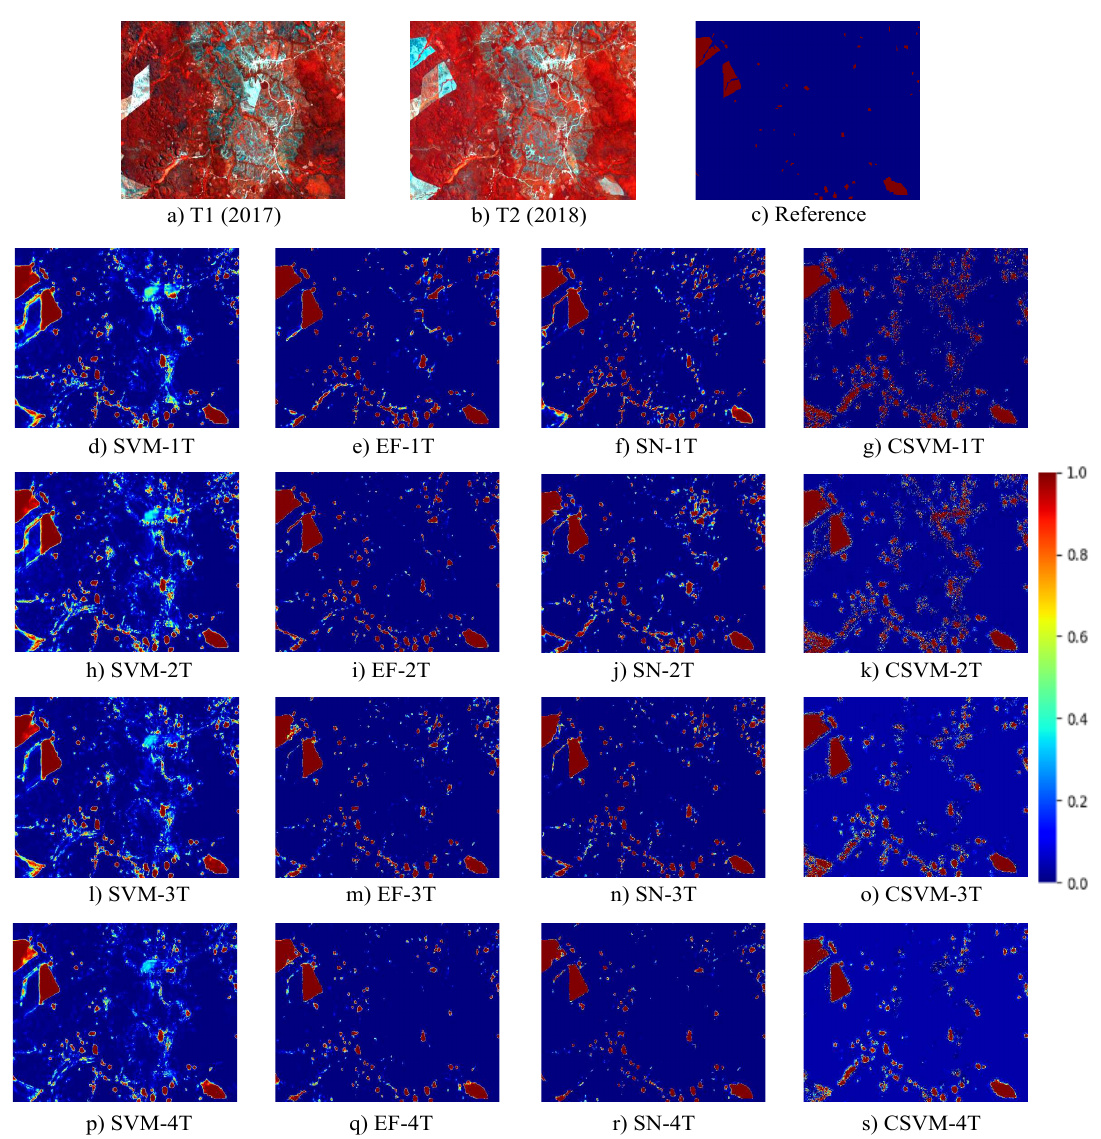
Figure 19. Predicted maps of tile 2 produced by SVM, EF, SN, and CSVM using one, two, three, and four tiles for